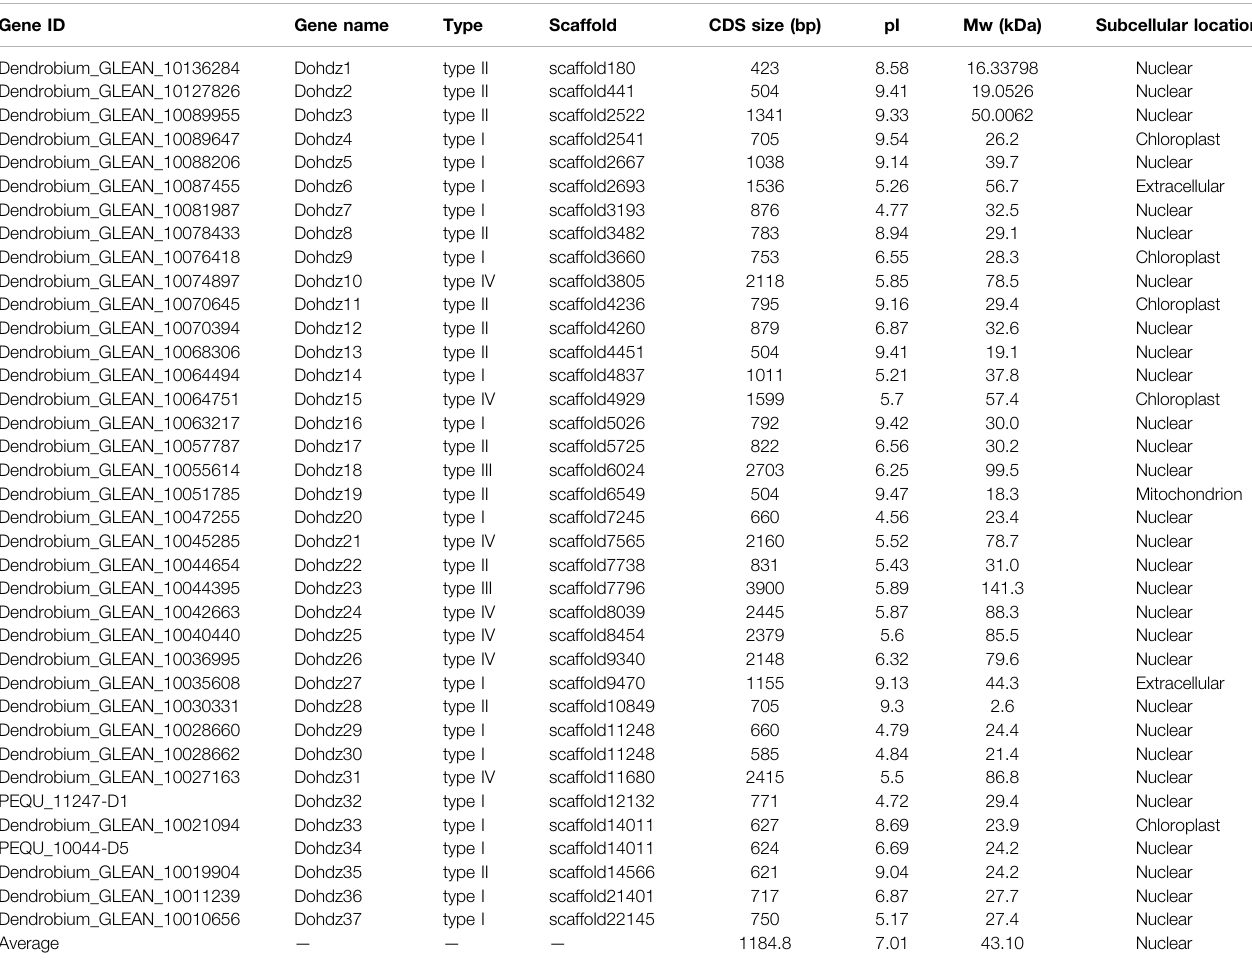
TABLE 1 | Basic information of the HD-ZIP genes identi fi ed in D. of fi cinale . Gene ID Gene name